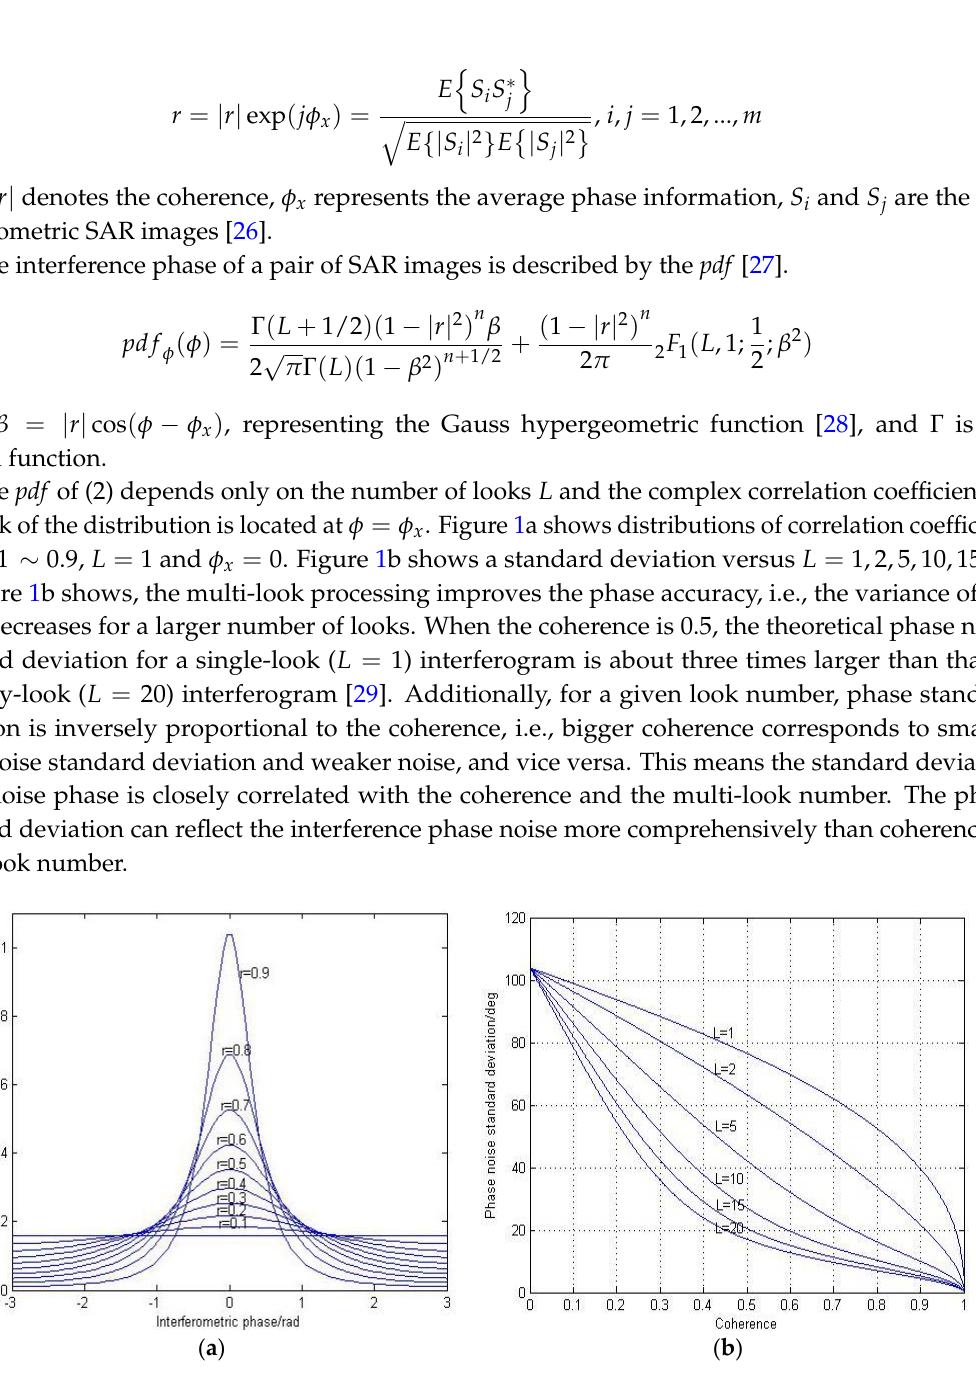
Figure 1. ( a ) Phase distribution for | r | = 0.1 ∼ 0.9 and phase φ x = 0 ; ( b ) Phase standard deviation versus coherence ( L indicates the multi-look number).